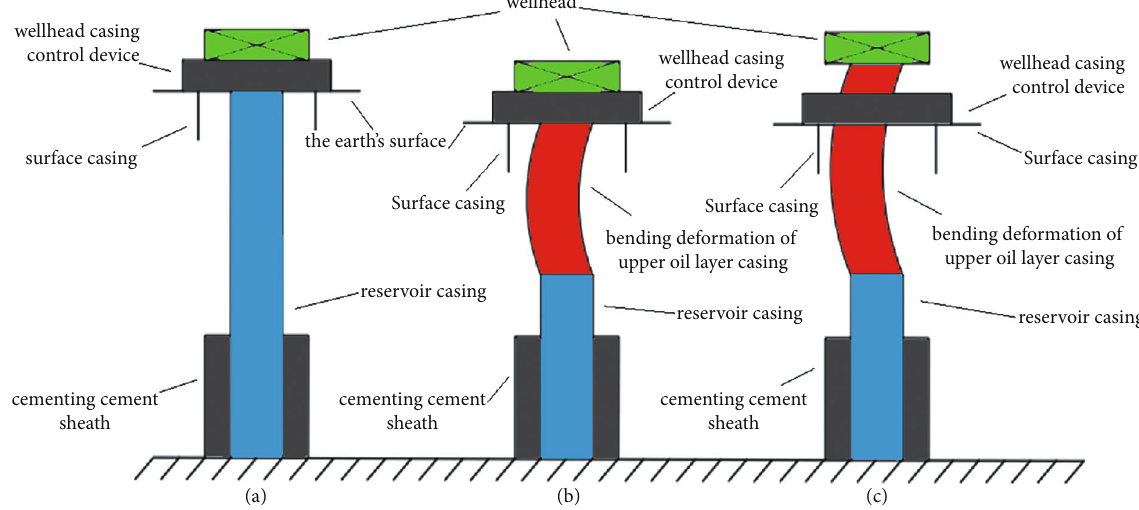
Figure 4: Deformation state of casing under di ff erent mechanical